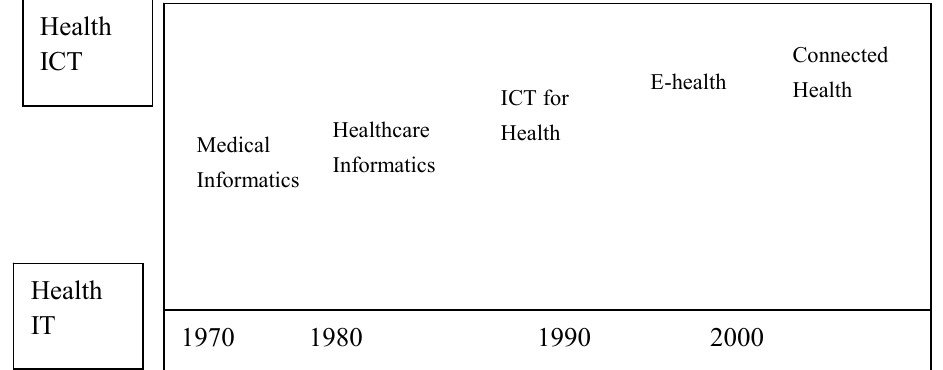
Figure 1. The evolution of names from ‘medical informatics’ to ‘connected health’ (Rossi Mori et al., 2007). The literature indicates that CH includes the whole Telemedicine (TM) family: Telemedicine Table 1. Comparison of telecare results in Taiwan with the combined results of North America and Europe.